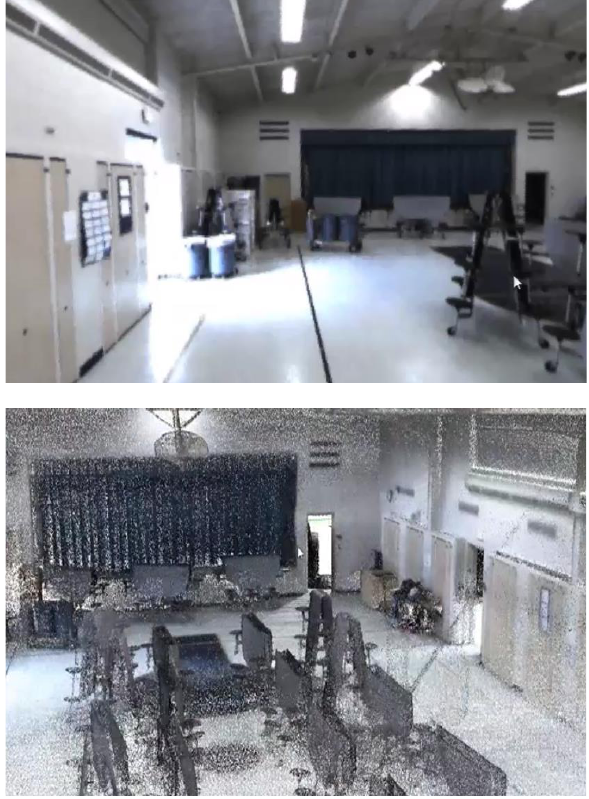
Figure 1 : Spherical imagery (top) and colorized point cloud (bottom) viewed in Paracosm’s Retrace and Rapidlasso’s LasTools software,